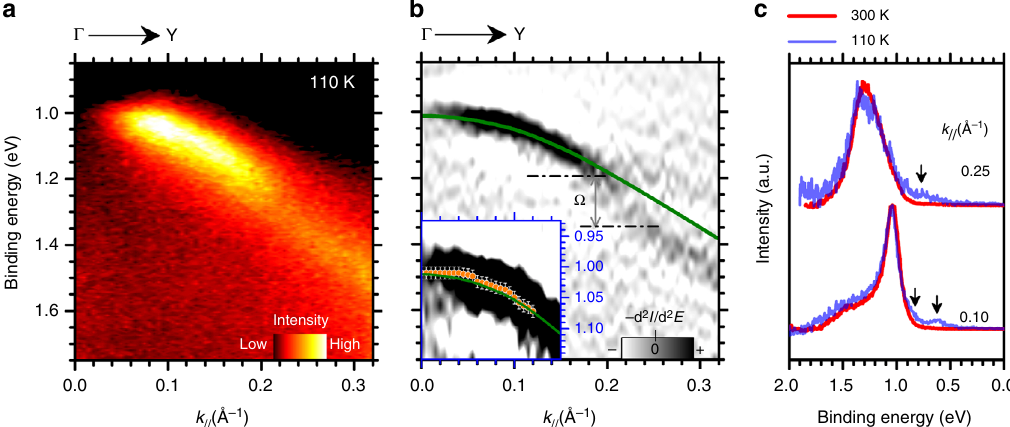
Fig. 3 Angle resolved band map at 110 K and theoretical calculations. a ARUPS intensities vs. k // along the Γ Y direction of rubrene single crystal at 110 K; b Second derivative ARUPS intensity map ( – d 2 I/d 2 E , where I is the ARPES intensity and E the binding energy) as obtained from data in a . The splitting of the HOMO band in two subband H U and H L is evidenced as separated by gap Ω . Inset: Magni fi cation of second derivative map close to Γ point. Experimental H peak positions are also indicated by orange circles and compared with theoretical band dispersion (continuous green line ) c HOMO-EDC curves (Shirley background subtracted, intensity normalized at the curve maximum) at k / / = 0.10 Å − 1 and k / / = 0.250 Å − 1 , as obtained at 300 K ( red line ) and 110 K ( blue line ). Peak like/tailing structure ( arrow ) are related to structural defects resulting from the temperature-induced mechanical stress in the